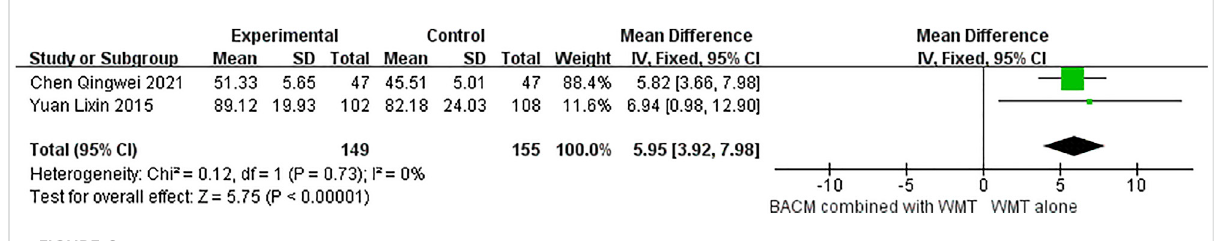
FIGURE 6 The forest plot of improved Barthel index by BACM for ICH.